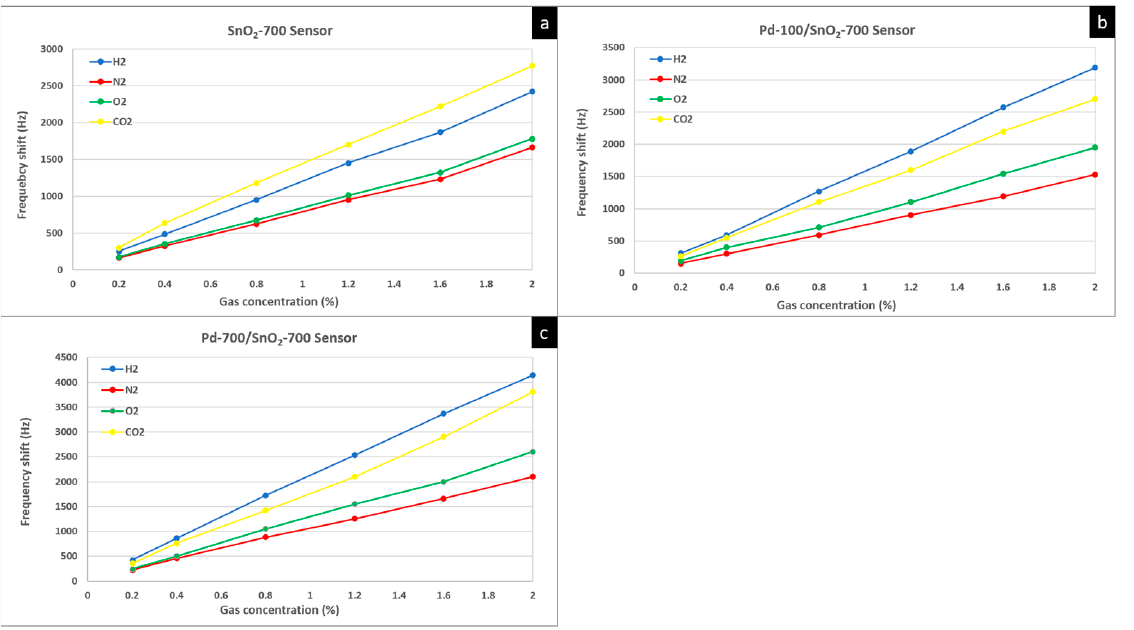
Figure 7. Frequency shifts of: ( a ) SnO 2 sensor, ( b ) Pd-100/SnO 2 -700 sensor and ( c ) Pd-700/SnO 2 -700 sensor, at different concentrations of H 2 , N 2 , O 2 and CO 2 .